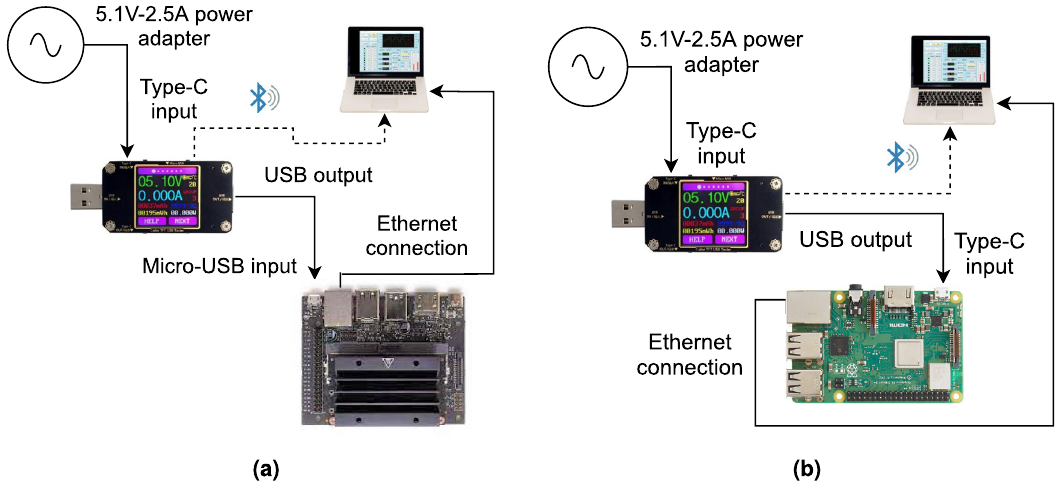
Figure 8. ( a ) The power measurement set-up for Nivida Jetson Nano, and ( b )—the same for Raspberry